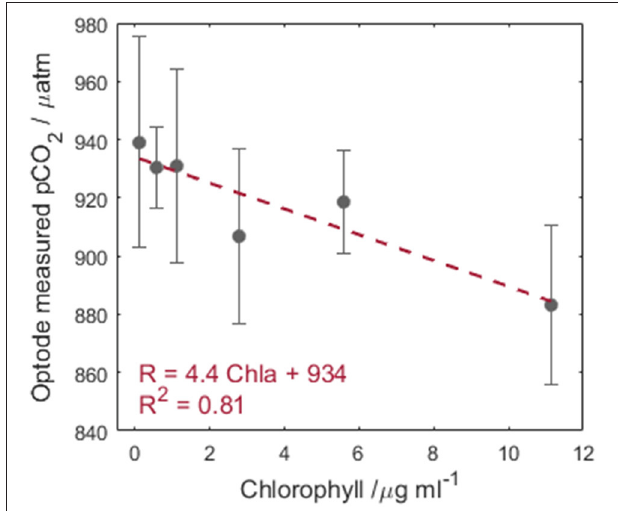
FIGURE 5 | Chlorophyll concentration vs. optode pCO 2 output. The error bars represent the standard deviation in the optode R across three repeat measurements. The red dashed line is a linear regression of the data, pCO 2 = − 4.4 Chla + 934 ( n = 6, R 2 = 0.81, p =